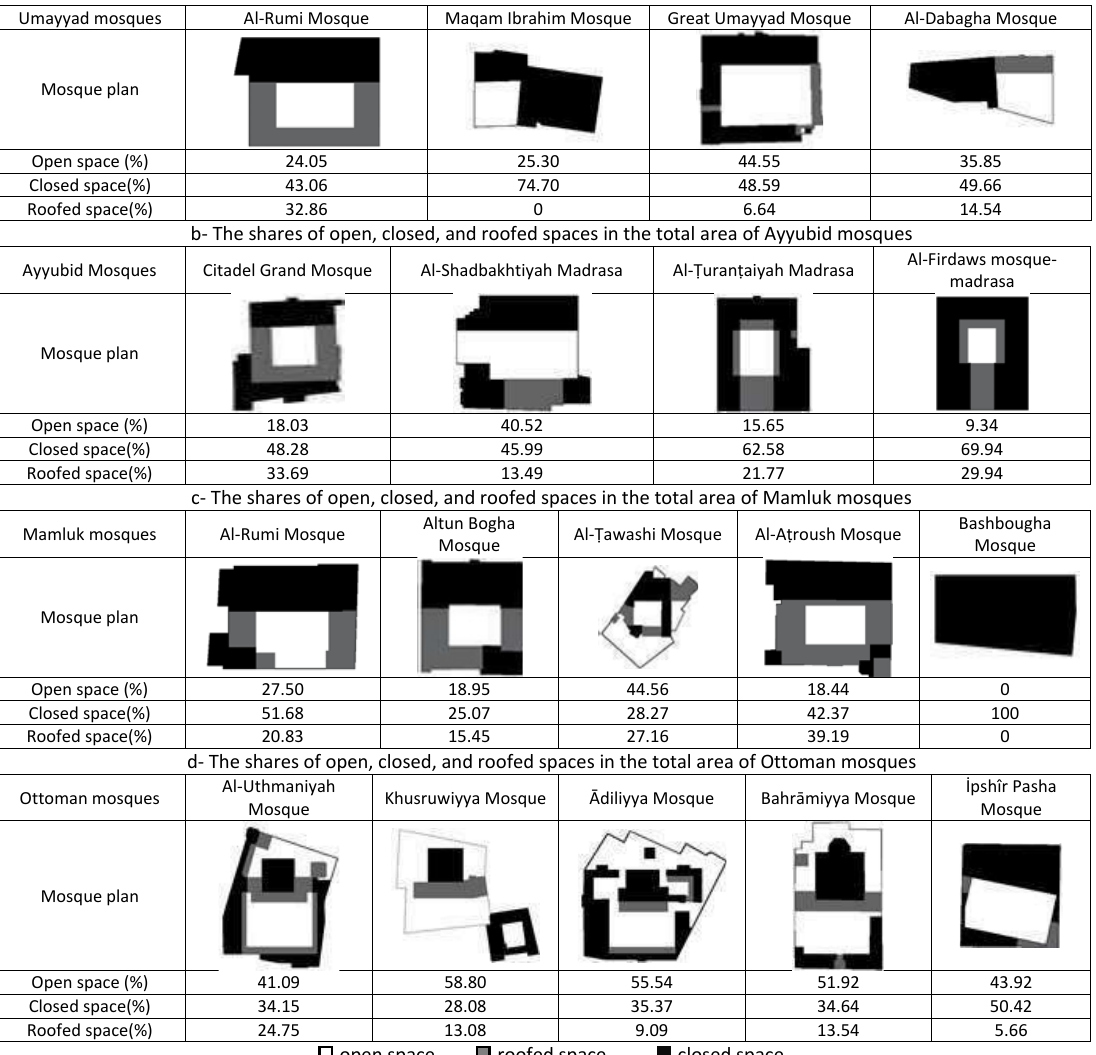
Table 1: The share of open, closed, and roofed spaces in the total area of historical mosques a‐ The shares of open, closed, and roofed spaces in the total area of Umayyad mosques